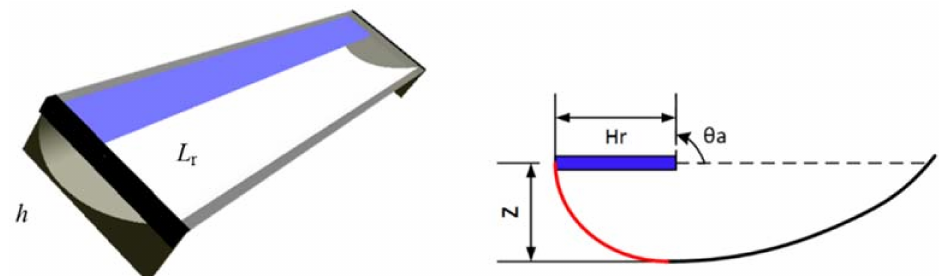
Figure 9. Standard Solarus concentrating photovoltaic thermal (C-PVT) collector.